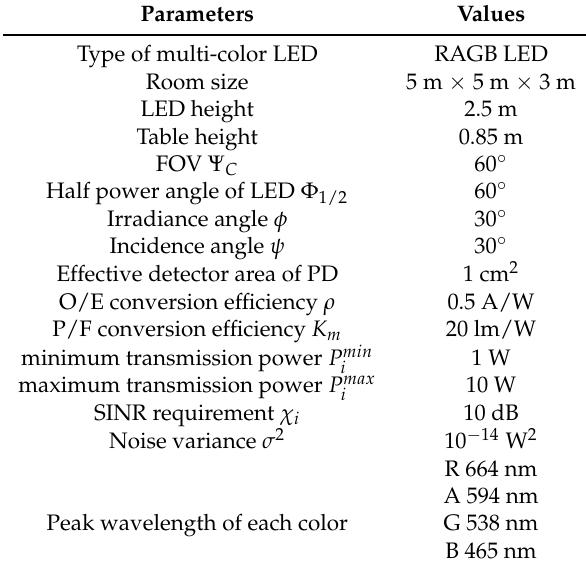
Table 2. Simulation parameters utilized in the RAGB LED VLC system. O/E, optical/electric; P/F, power to luminous